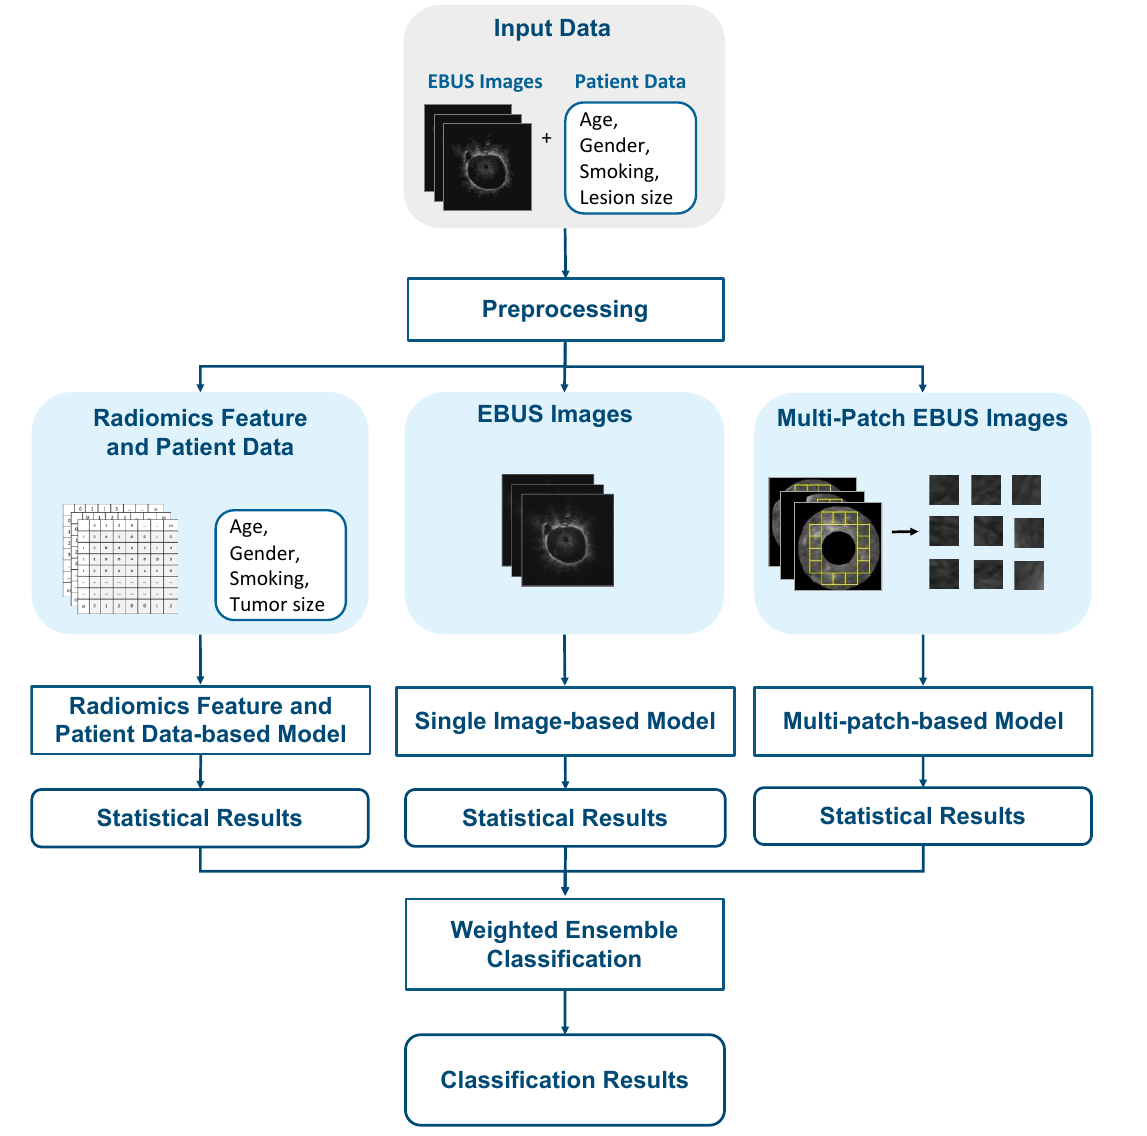
Figure 2. The framework of the proposed pulmonary lesion classification system.